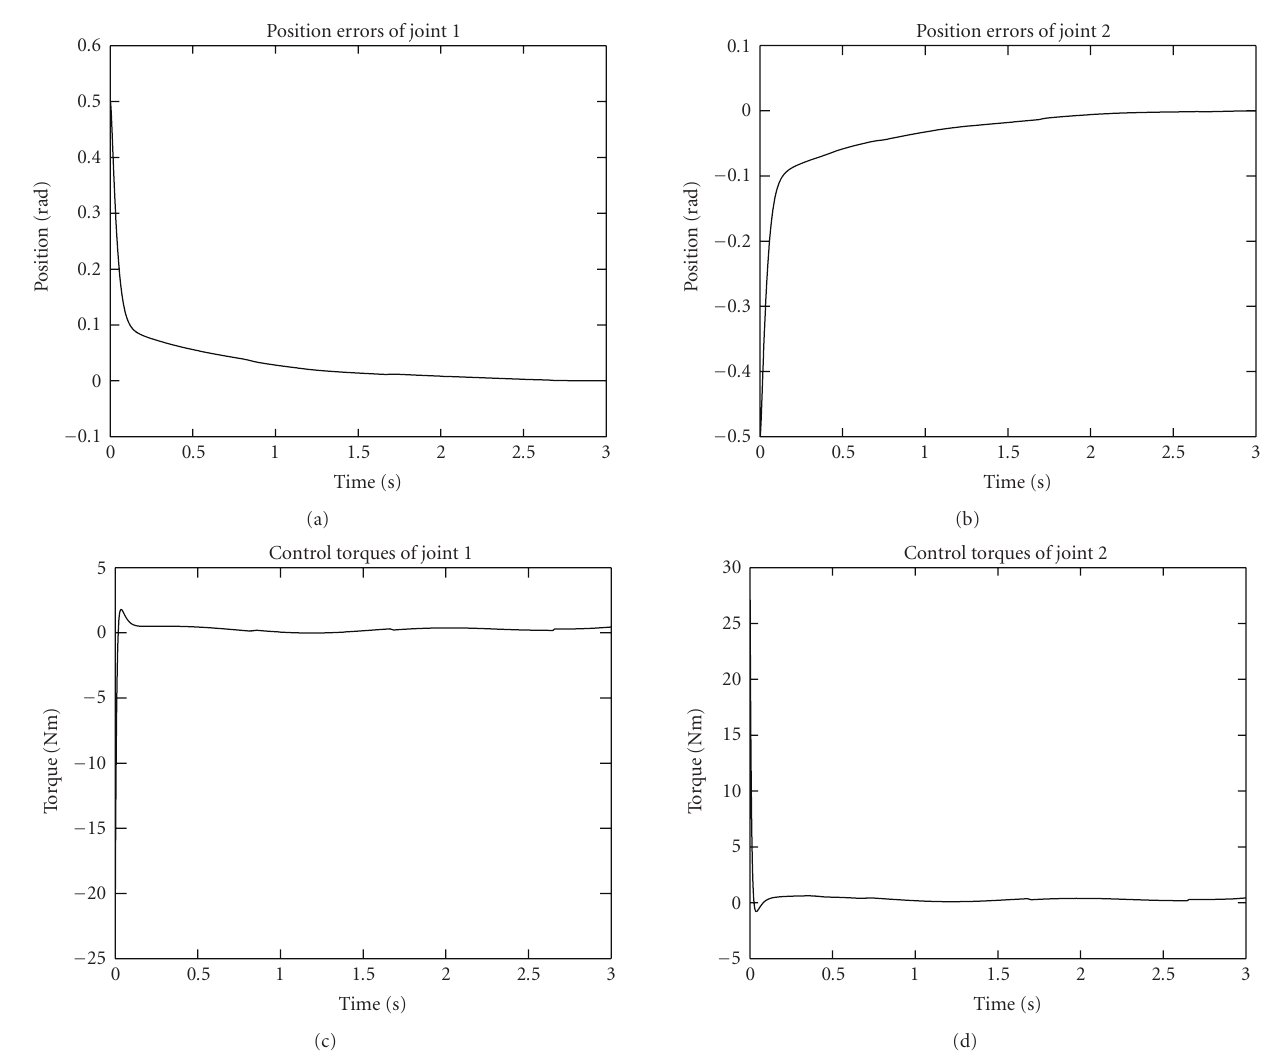
Figure 4: Response using proposed intelligent robust control law ( α = 10, η = 0 .